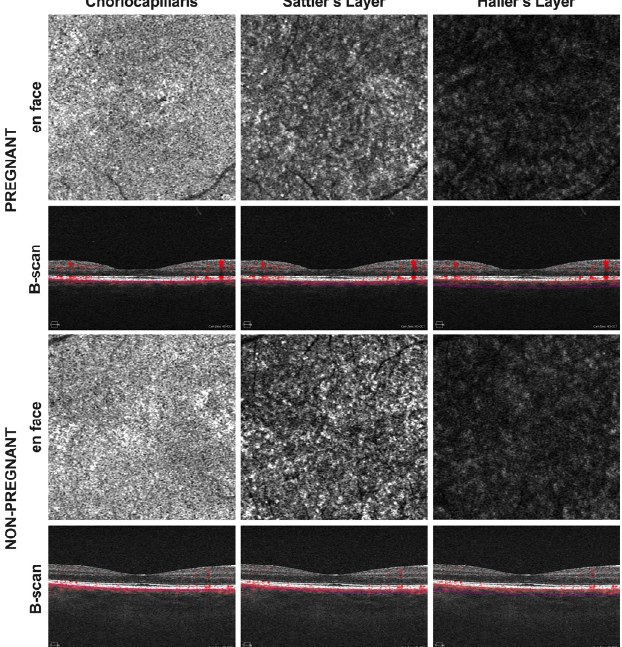
Figure 1. Optical coherence tomography angiography (OCTA) images were acquired in pregnant as well as non-pregnant women. En face angiograms and corresponding B-scans of the choriocapillaris, Sattler’s layer, and Haller’s layer were generated using the CIRRUS 5000 OCT device with AngioPlex software. En face images were then processed for quantitative analysis using ImageJ.